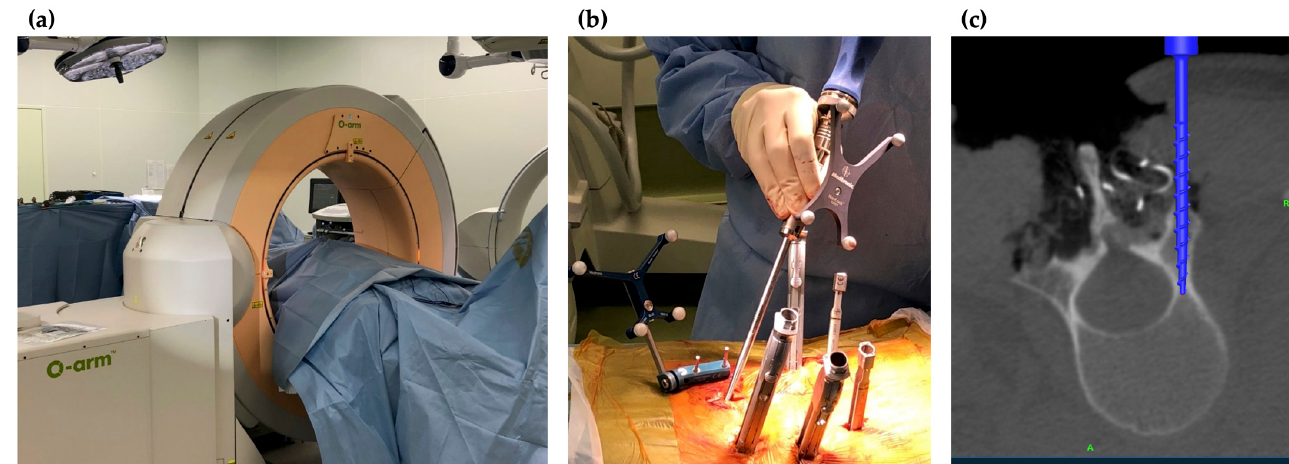
Figure 2. Intraoperative images of O-arm ® navigation. ( a ) Setting of O-arm ® ; ( b ) insertion of pedicle screws under CT navigation; ( c ) reconstruction CT image on the navigation monitor.